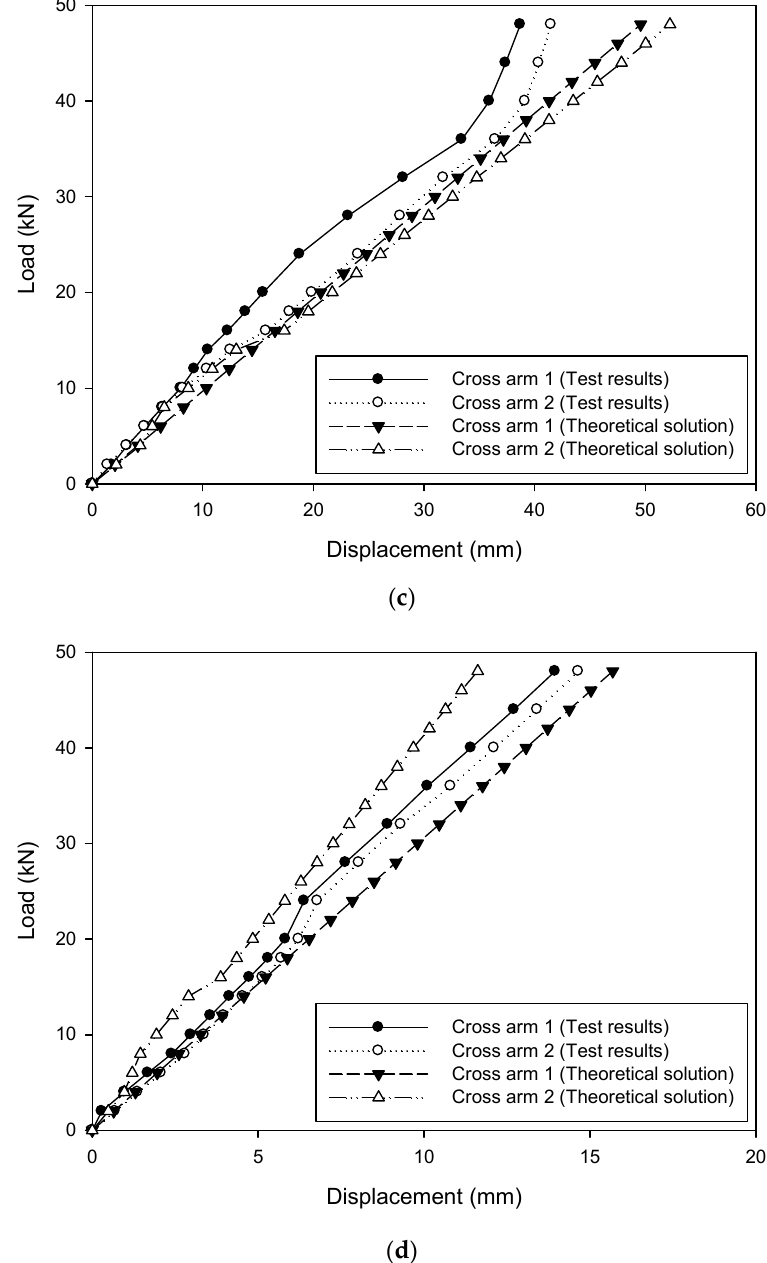
Figure 12. Comparison between the theoretical solution and experimental results: ( a ) Specimen D150-30; ( b ) specimen D150-40; ( c ) specimen D300-45; ( d ) specimen D300-60.